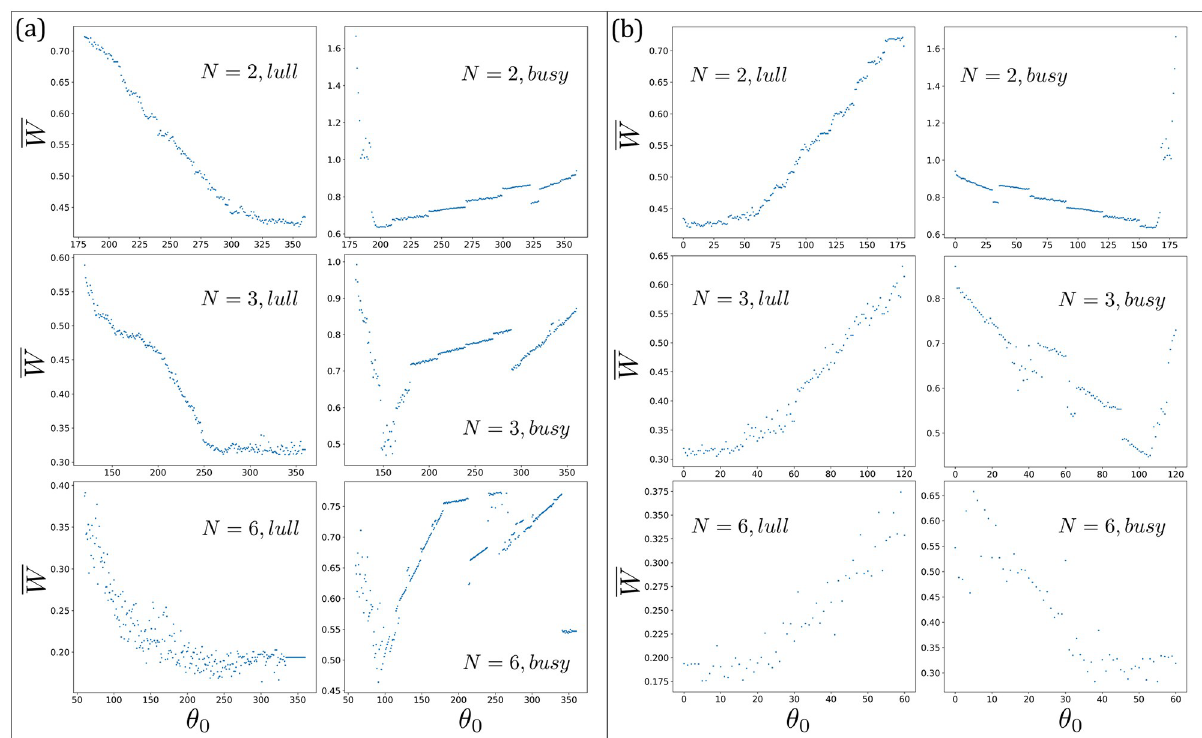
Fig 8. (a) Simulation results for N = 2, 3, 6 buses, respectively, serving M = 12 bus stops in a loop. The no-boarding policy is applied by looking at the bus immediately ahead. Note that θ 0 = 360˚ corresponds to no-implementation. The left column is in the lull phase where the no-boarding policy backfires and increases the passenger waiting time, as compared to no implentation (or 360˚). On the other hand, the right column is in the busy phase where the no-boarding policy correctly reduces the average waiting time as expected, by preventing the buses from forming permanent bunched clusters. (b) The corresponding simulation results as in (a), but with the no-boarding policy by looking at the bus immediately behind. Note that θ 0 = 0˚ corresponds to no-implementation.